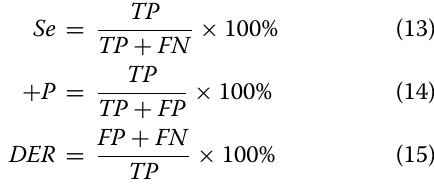
The performance evaluation of the proposed method for 47 ECG recordings (except 108 recording) of the MIT- BIH arrhythmia database are summarized in Table